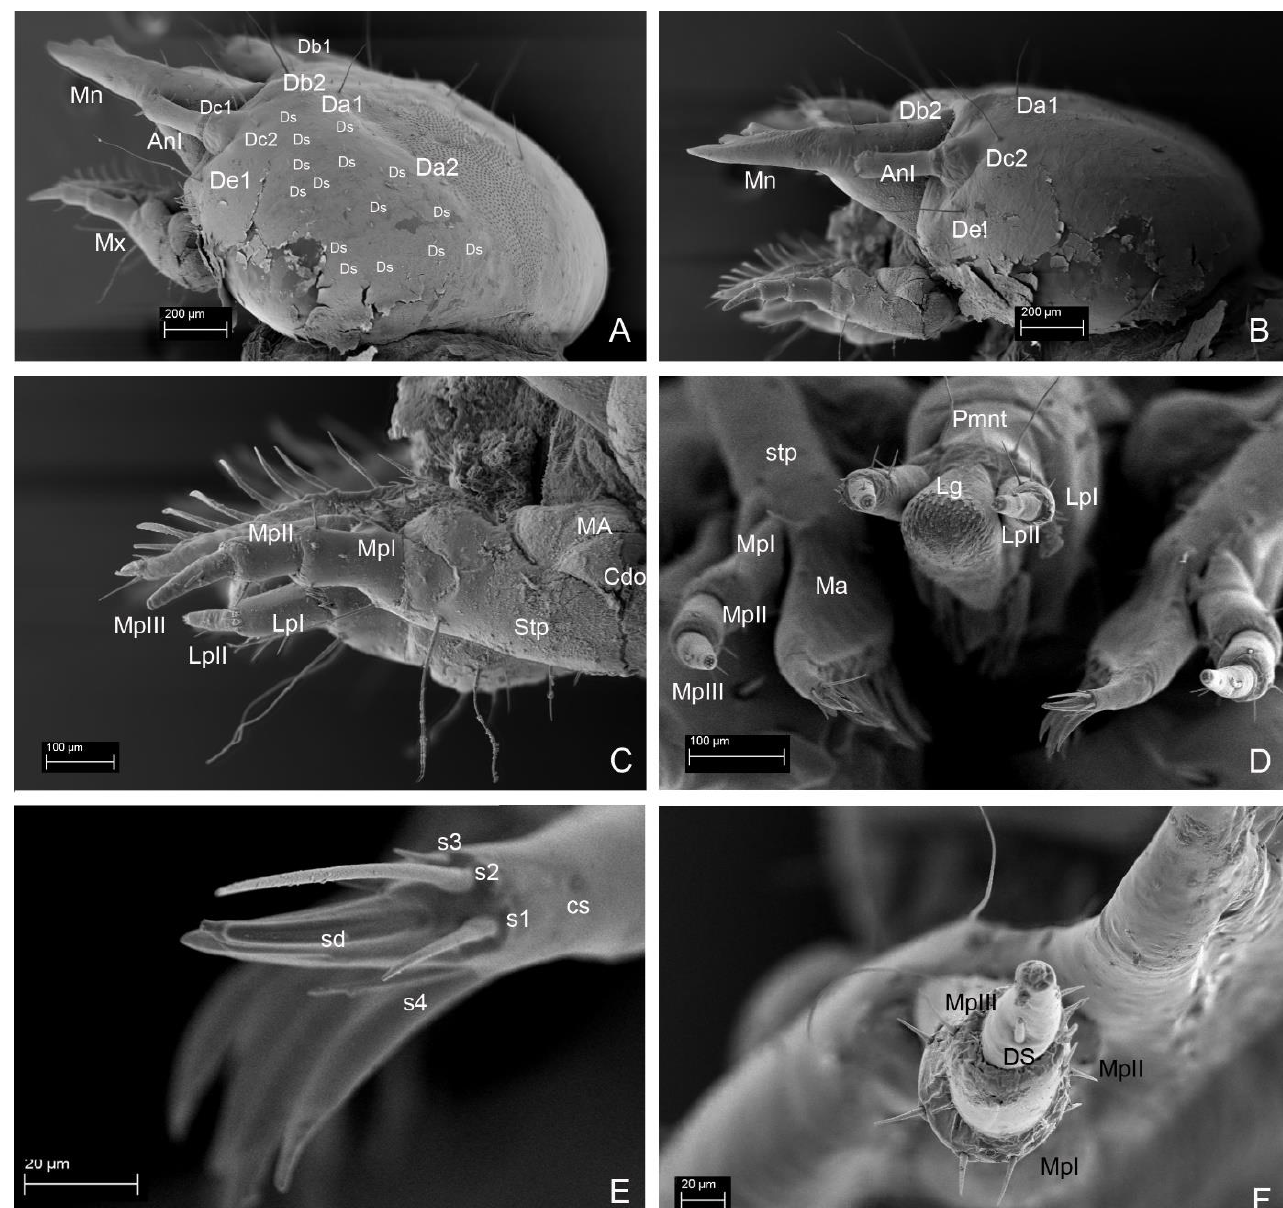
Figure 9. Leiodes cinnamomea . Details of larval morphology of instar III. ( A ) Head in dorso-lateral view. ( B ) Head in lateral view. ( C ) Maxilla, lateral view. ( D ) Labium and maxillae, apical view. ( E )